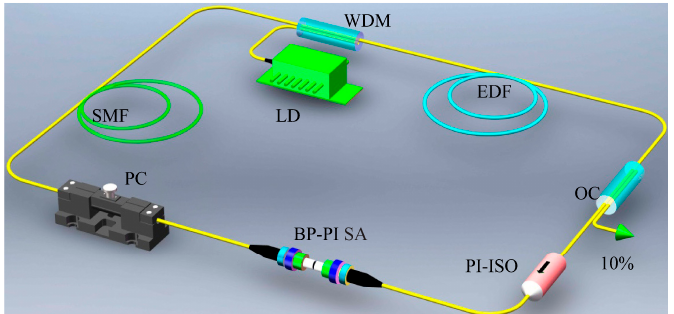
Figure 3. ( a ) Scheme of the balanced twin-detector system; ( b ) nonlinear transmission of BP–PI saturable absorber (SA).